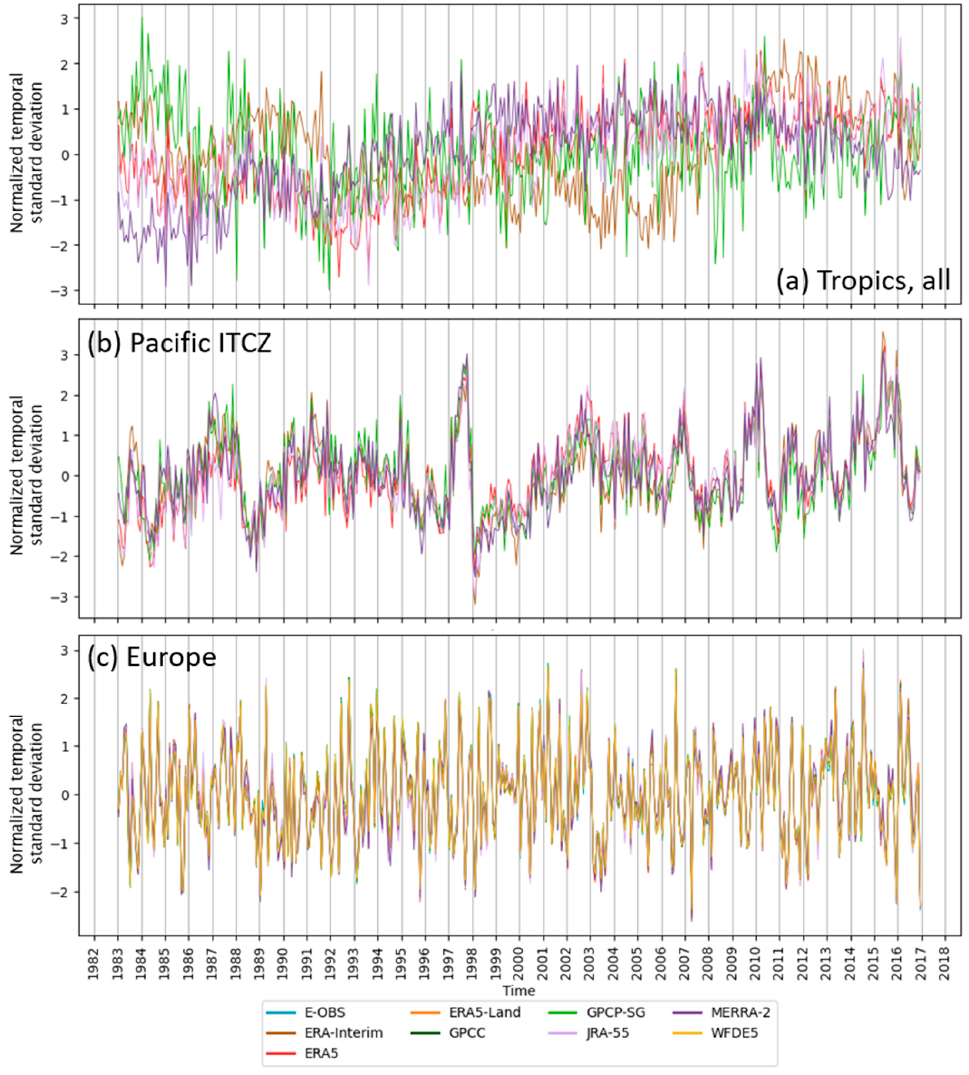
Figure 9. Times series of area ‐ averaged monthly mean anomalies of precipitation rates for ( a ) the entire Tropics, ( b ) the Pacific ITCZ and ( c ) Central Europe calculated with respect to the respective dataset climatology for the period 1983–2016. Anomalies are shown in multiples of the temporal standard deviation.